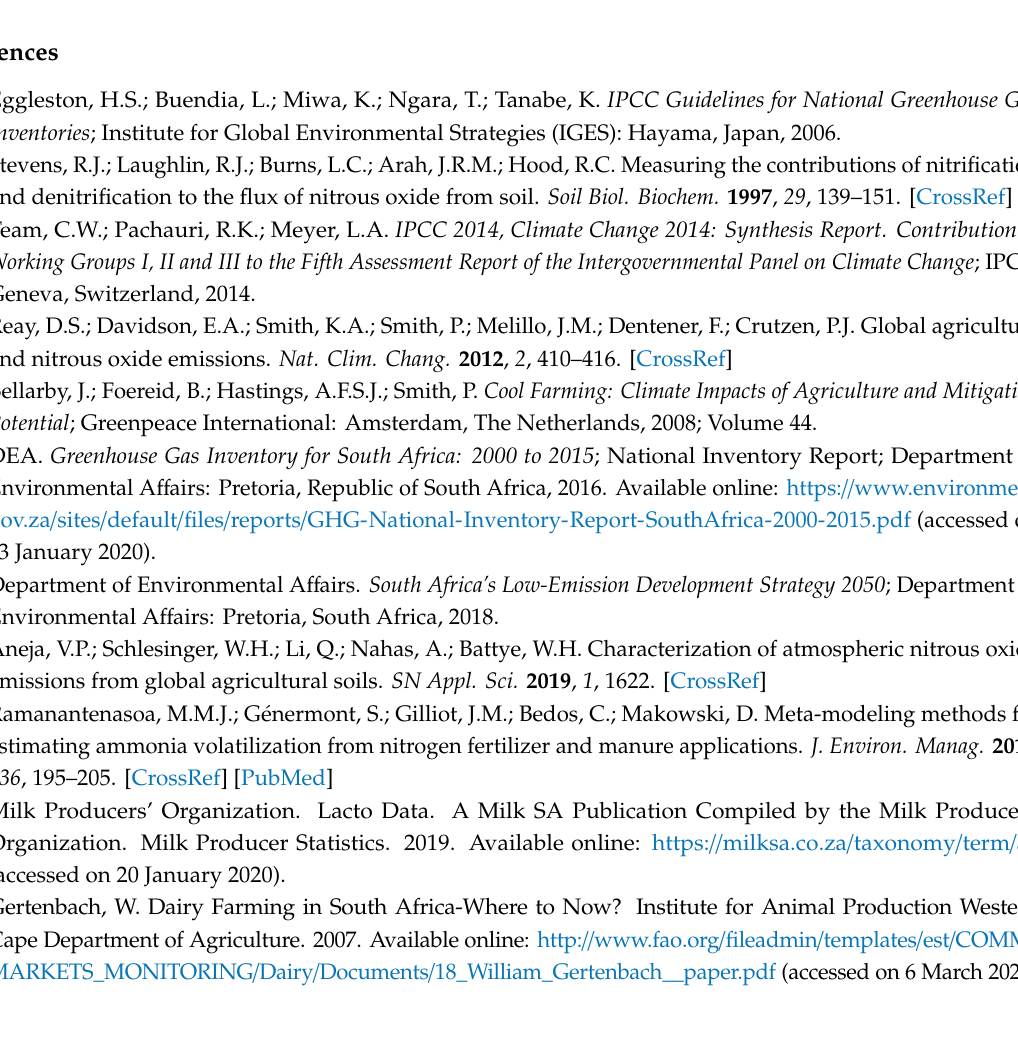
Table S1: The mean mineralizable nitrogen (N min ), NH 4 + -N, NO 3 − -N, and WFPS for the di ff erent N fertilization treatments (N0, N20, N40, N60, and N80) for soil depth 0–10 cm, during the trial period (June 2018–June 2019). The standard error of the mean is shown in brackets. The N0, N20, N40, N60, and N80 refer to the di ff erent treatments used and were 0, 220, 440, 660, and 880 kg N ha − 1 year − 1